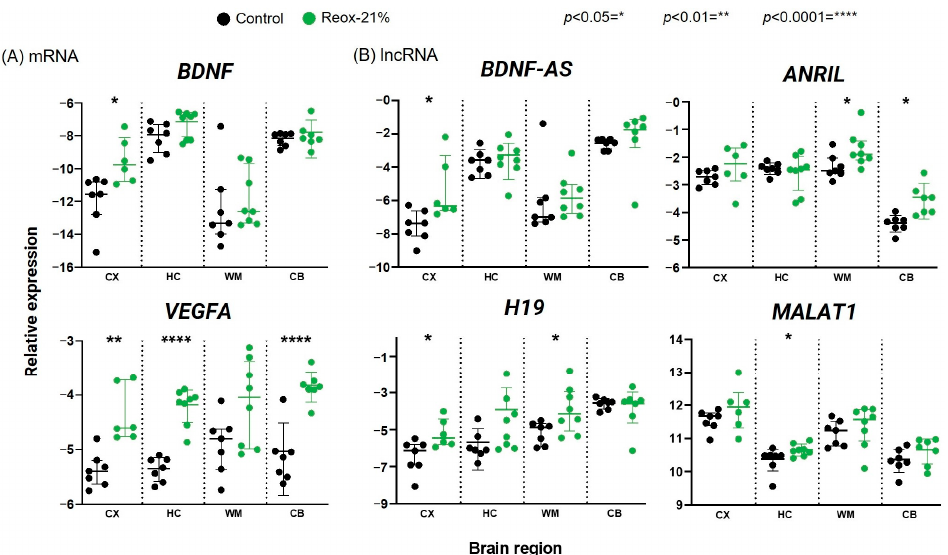
Figure 2. Differential expression of hypoxia- and oxidative-stress-regulated mRNAs ( A ) and lncRNAs ( B ) in the cortex (CX), hippocampus (HC), white matter (WM), and cerebellum (CB) of the brain in a perinatal asphyxia piglet model, analyzed using qPCR. The control group was exposed to 21% O 2 during the entire procedure, while the Reox-21% group was exposed to hypoxia (8% O 2 ) followed by normoxic reoxygenation (21% O 2 ). Relative gene expressions (2 −∆ Ct ) are shown on a log scale and expressed as either mean ± SD ( VEGFA : HC, WM, CB; BDNF : CB; BDNF-AS : HC, CB; H19 ; MALAT1 ; ANRIL ) or median ± IQR ( VEGFA : CX; BDNF : CX, HC, WM; BDNF-AS : CX, WM).